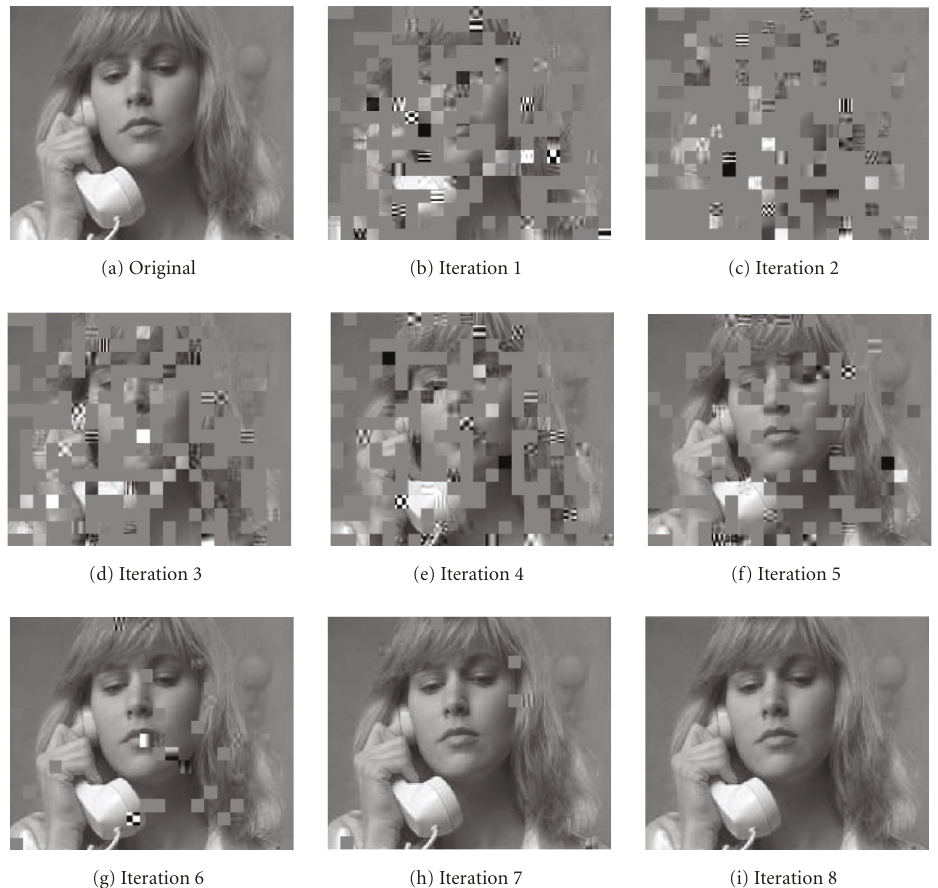
Figure 16: Original and decoded “Suzie” images over Rayleigh fading channel using typical turbo code with an E b /N 0 of 6dB, f d = 185Hz.